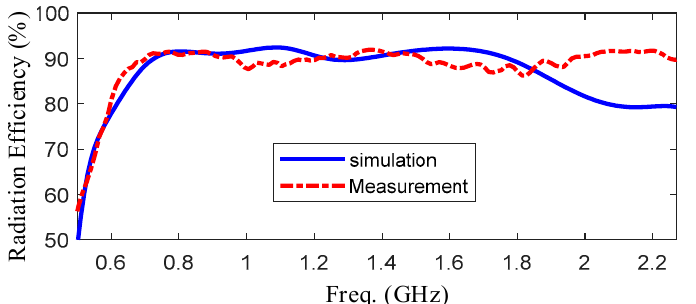
Figure 18. The comparison of realized gain between measurement and simulation.